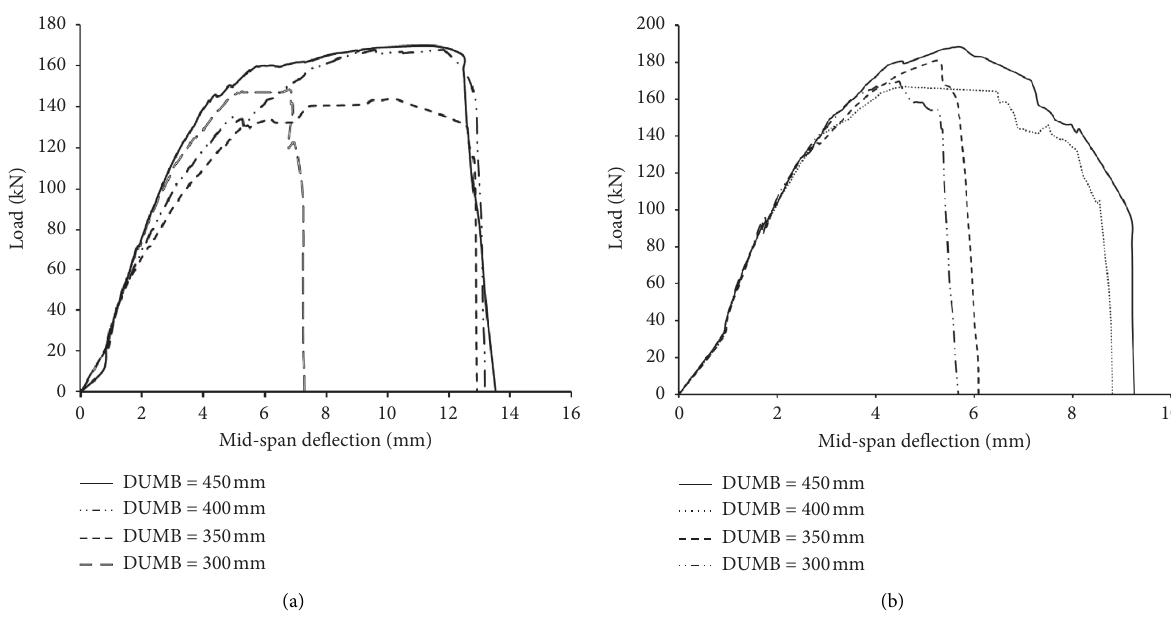
Figure 17: Load-deflection curves of the beam SU10C30 strengthened by the different DUMBs. (a) Beam U10C30 and (b) Beam